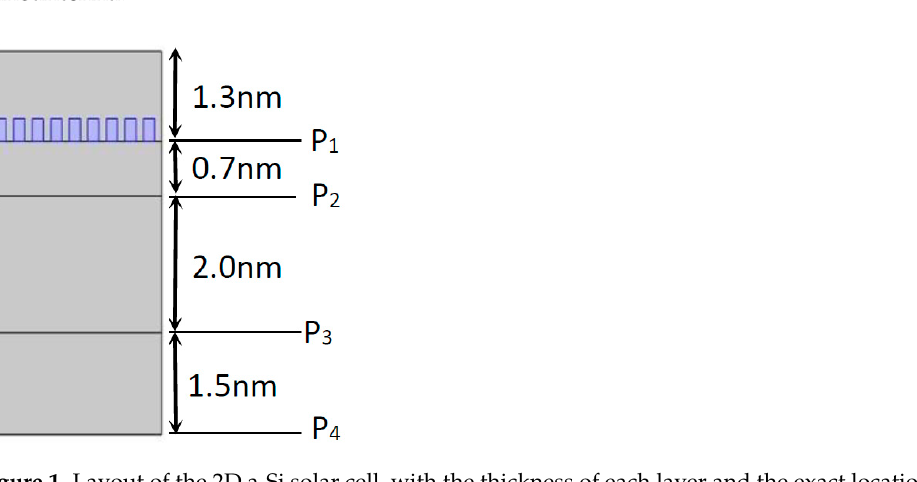
Figure 1. Layout of the 2D a-Si solar cell, with the thickness of each layer and the exact location of each probe.